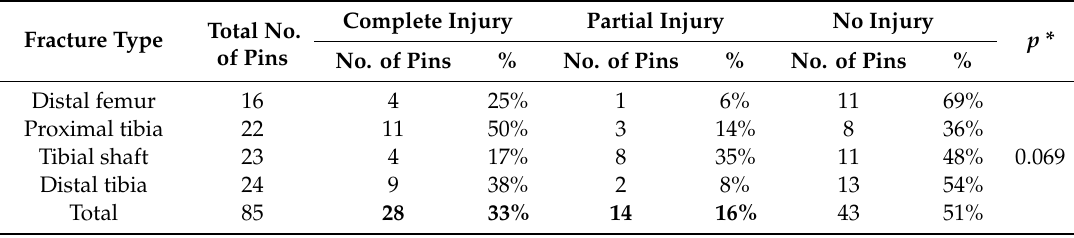
Table 4. The incidence of the TNAC injury via pins applied at the level of the TNAC according to the external fixator type.